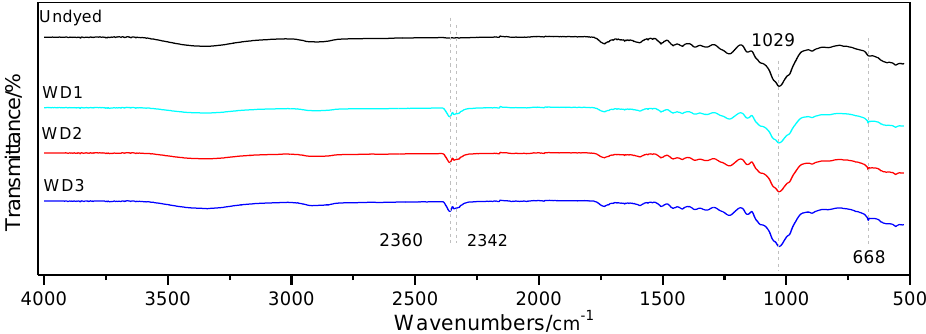
Figure 6. Changes of chemical components of poplar wood in vertical and horizontal dyeing by Lasiodiplodia theobromae after 40 days under different induction factors.